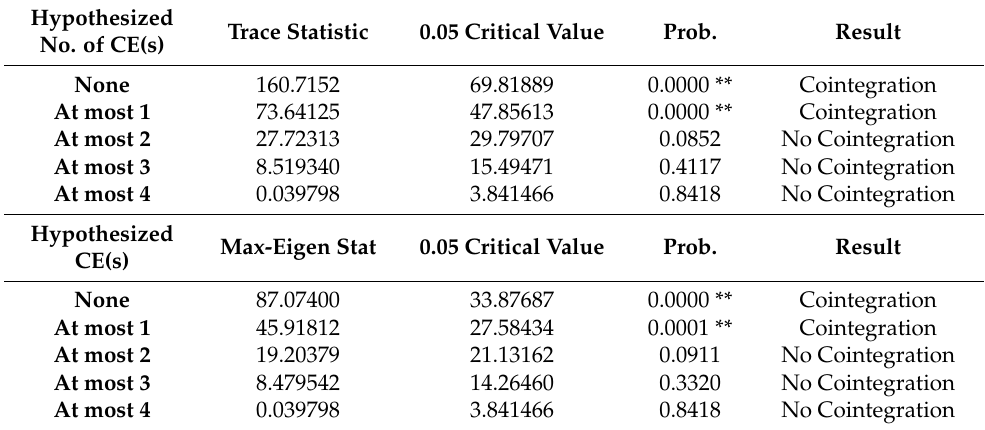
Table 5. JJ model for main-season